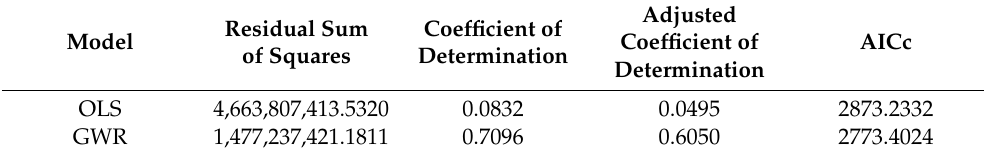
Table 8. Comparison of fitting results between the OLS model and the GWR model. Residual Sum Coefficient of Model of Squares